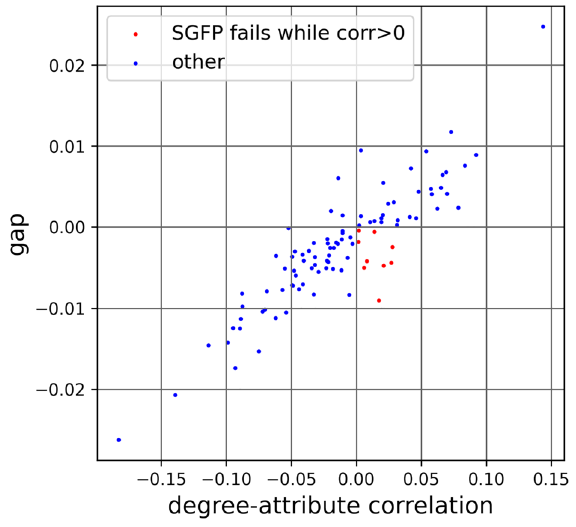
Figure 5. Plotting r d , a and the gap for 100 Facebook100 networks with “proportion of friends with the same reported gender” (including NULL) as attribute. For 9 schools, the gap is negative while r d , a is positive. These are real-world examples of failing SGFP with attributes positively correlated with